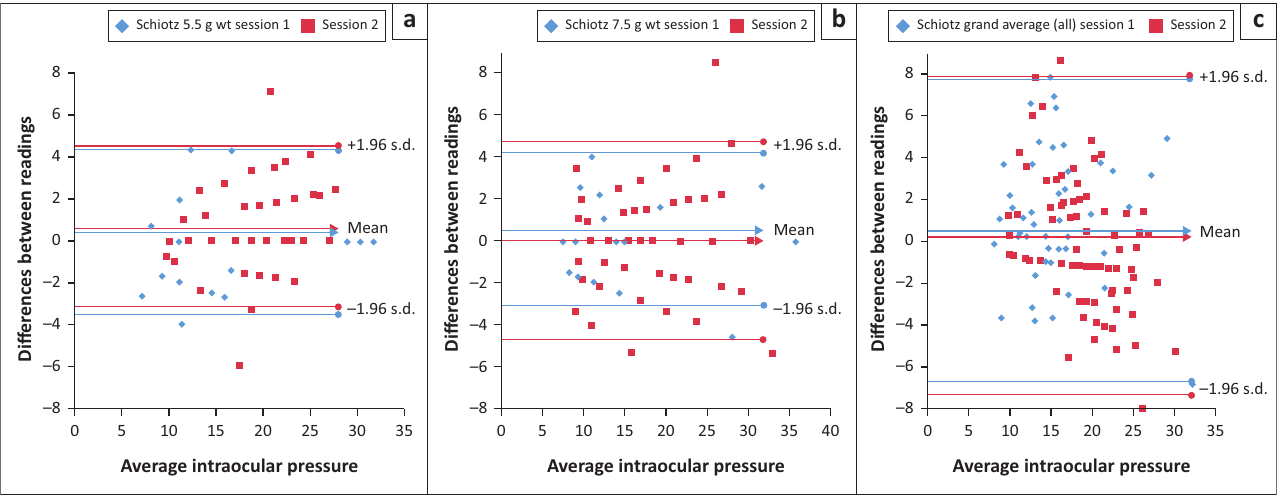
FIGURE 3: Limits of within-session repeatability for Schiøtz Indentation Tonometer, measurements are in mmHg: (a) 5.5 g weight, (b) 7.5 g weight and (c) average of 5.5 g and 7.5 g